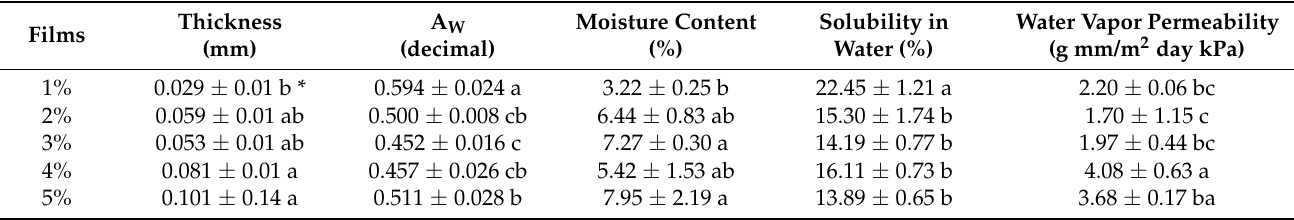
Table 1. Thickness, water activity (Aw), moisture content, water in solubility and water vapor permeability values ob- tained for films produced with different concentrations of arrowroot starch in film-forming solution. Films